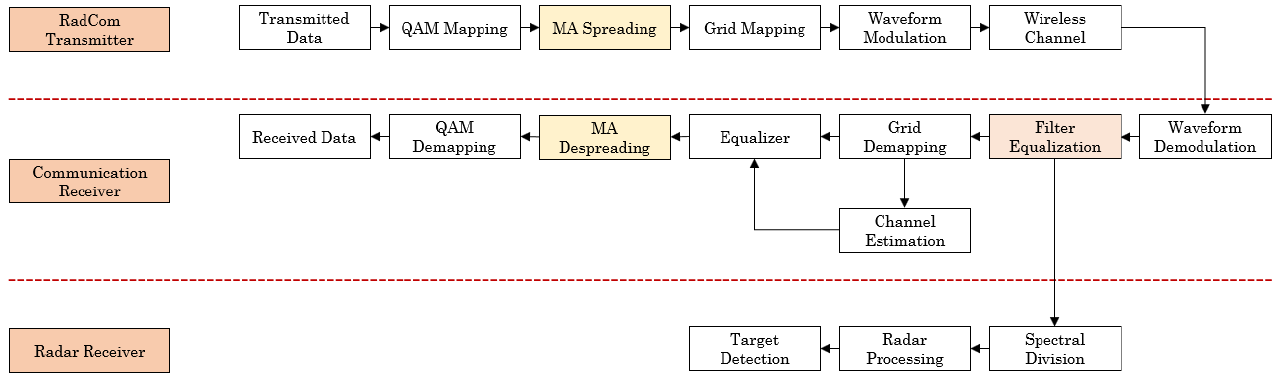
Figure 2. RadCom system